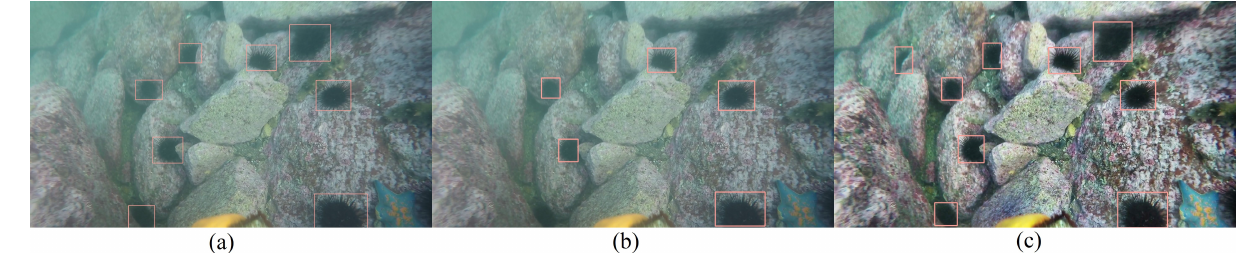
Figure 6. Demonstration of the proposed approach: GT of sea urchins ( a ); YOLOv5s prediction ( b ); TC-YOLO prediction ( c